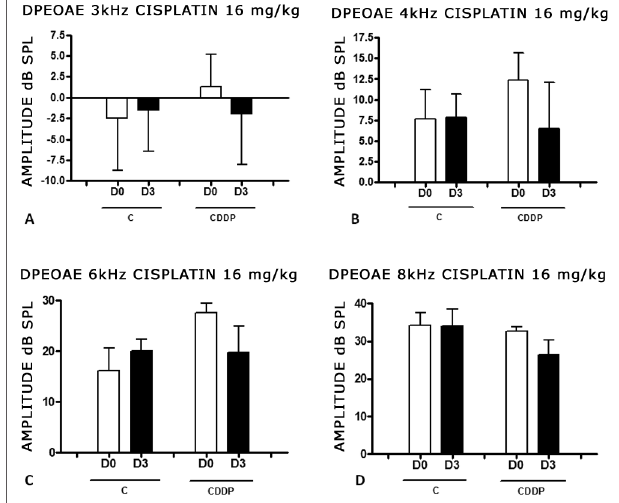
Figure 4. Graph of the DPEAOAE amplitude values expressed as mean ± mean standard error in the averages of days D0 and D3, for groups 5 and 6. CDDP = cisplatin; C = control. There was no statistical significance in any of the groups (T test: p > 0.05).